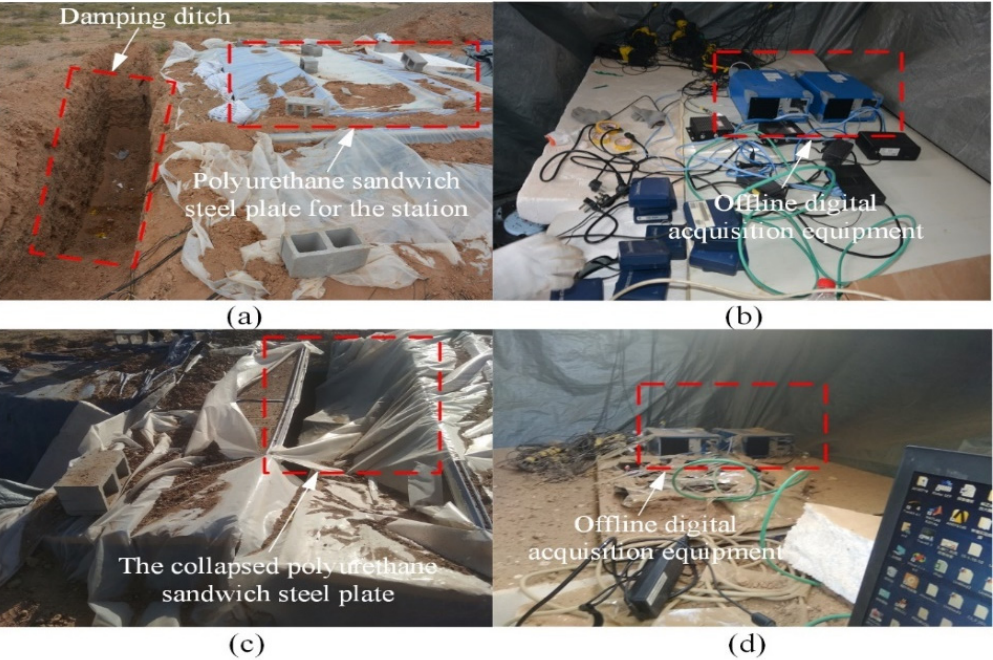
Figure 4. Photographs of the measurement station before and after the 10 t TNT test, ( a , b ) photographs of the inside and outside of the station before test, ( c ) photograph of the outside of the station after the 10 t TNT test, ( d ) photograph of the inside of the station after the 10 t TNT test. No test data could be acquired on the 10 t TNT test, because all the wires leading to